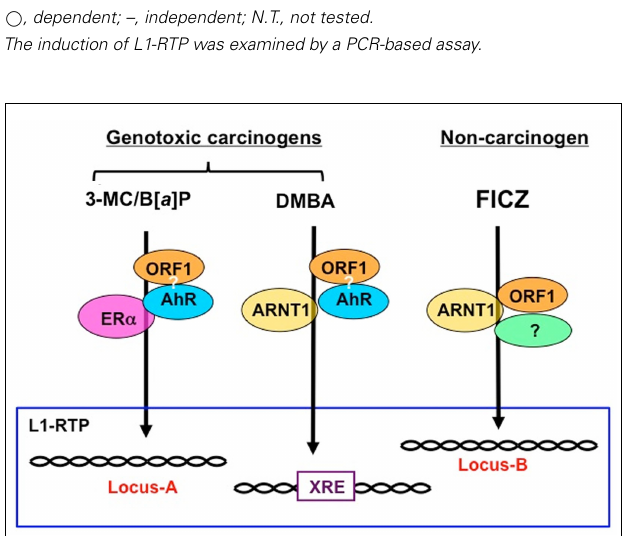
FIGURE 1 | Schematic modes of L1-RTP triggered by environmental compounds. Given that ORF1, which associates with retroelements, is recruited to the chromatin, regions of L1-RTP are likely determined by the binding partners of ORF1. As shown in Table 1 , the induction of L1-RTP by environmental compounds depended on different sets of bHLH/PAS proteins.The induction of L1-RTP by DMBA depended on AhR and ARNT1, whereas that by 3-MC and B[ a ]P required AhR. Interestingly, L1-RTP by 3-MC and B[ a ]P did not require ARNT1, but depended on ER α . By contrast, FICZ-induced L1-RTP depending on ARNT1, whereas it did not require AhR. It is plausible that the regions where these compounds insert L1 are different: DMBA induces L1-RTP in the vicinity of XRE, whereas 3-MC and B[ a ]P induce L1-RTP in the region determined by AhR and ER α .The locus of L1-RTP by FICZ would differ from those determined by these genotoxic carcinogens.To prove this, it is necessary to identify the association of ORF1 and AhR and genome regions where L1 is inserted in response to each environmental